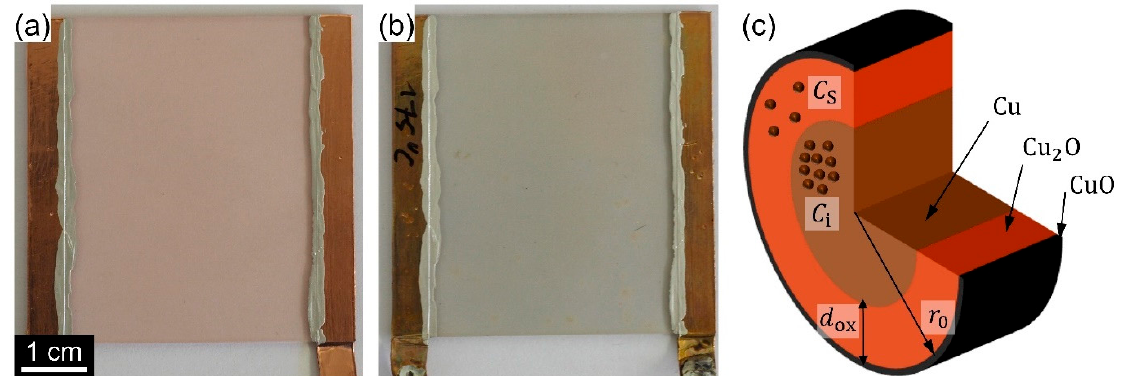
Figure 12. Photos for ( a ) an as-deposited CuNW film and ( b ) a CuNW film subjected to a temperature of 175 °C for a duration of 1 h. ( c ) Schematic of an oxidized CuNW along with the parameters that are used in the text to describe the oxidation mechanism.